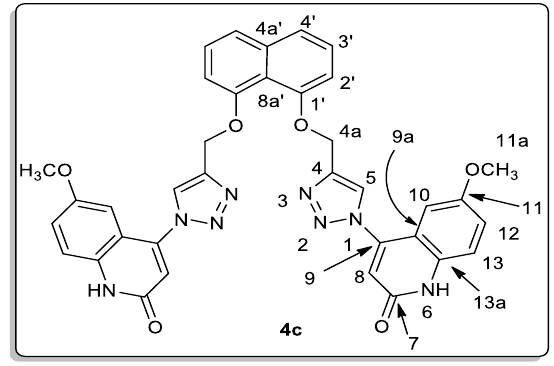
Figure 4. Structure for compound 4c .